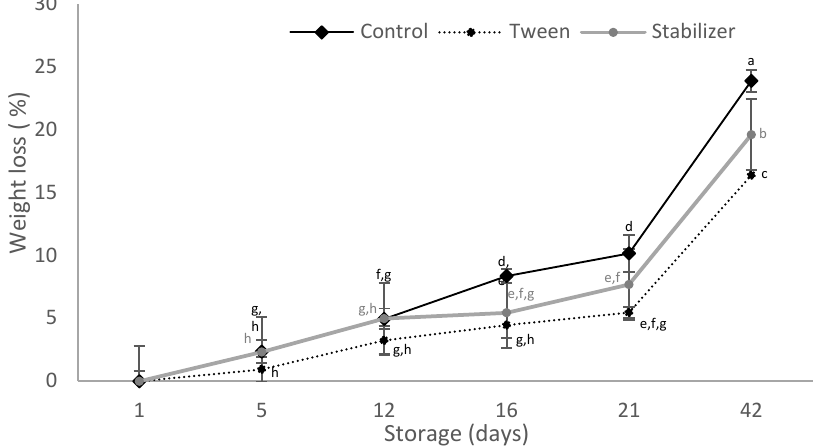
Figure 4. Weight loss of zucchinis during 42 days of storage. The data are mean ± SD of three replicates from two zucchinis. Different letters indicate significant differences with ANOVA and Tuckey post-hoc test at p < 0.05.